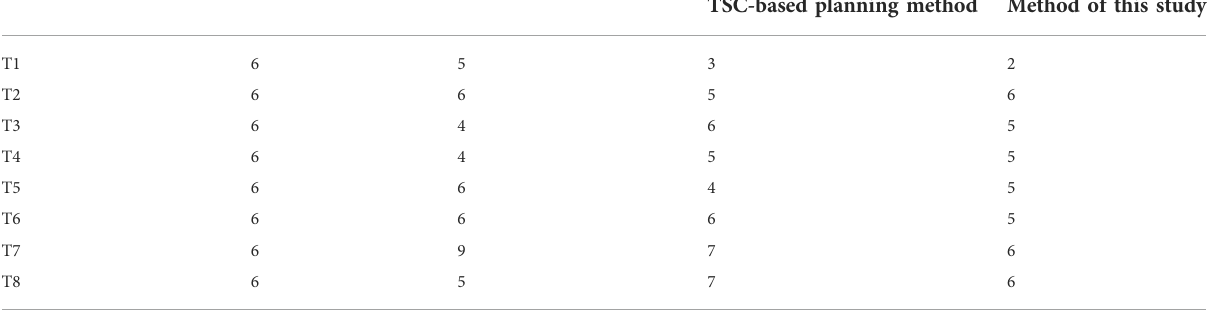
TABLE 4 Total data of feeder links of substation transformers.